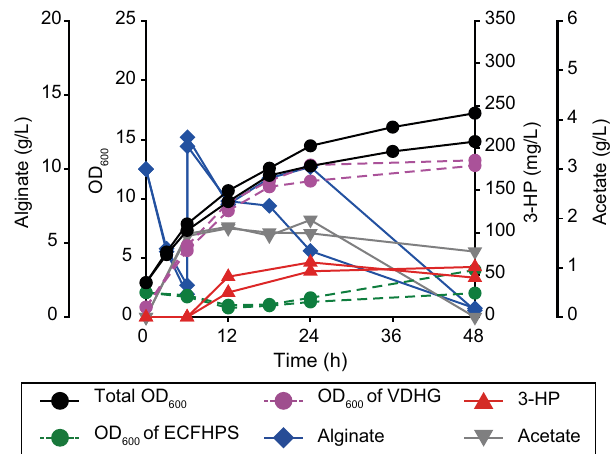
Fig.2|3-HPproductionfromalginatebythemicrobialconsortiumcomprising VDHG and ECFHPS strains. Fermentation pro fi le of the co-culture of the VDHG and ECFHPS strains. The left y -axis and left y -offset represent OD 600 (black circles) and consumed alginate (blue diamond, g/L), respectively. Estimated OD 600 of the VDHG (purple circles) and ECFHPS (green circles) strains was also provided. The right y -axisandright y -offsetrepresent3-HP(redtriangles,mg/L)andacetate(grey inverted triangles, g/L) levels, respectively. Source data are provided as a Source Data fi